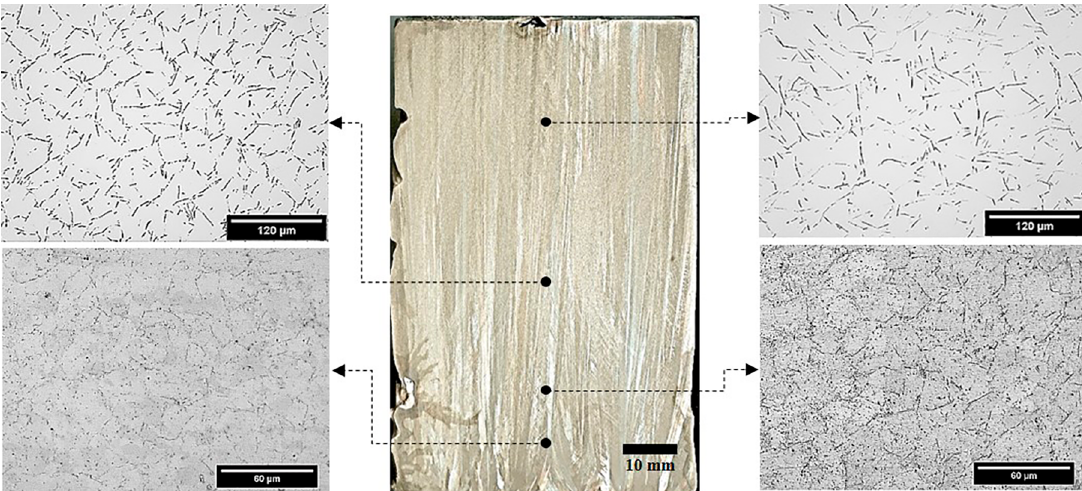
Figure 5. Columnar grains macrostructure and selected transverse microstructures showing the β-Sn morphological evolution across the Sn-0.2wt.%Ni alloy casting